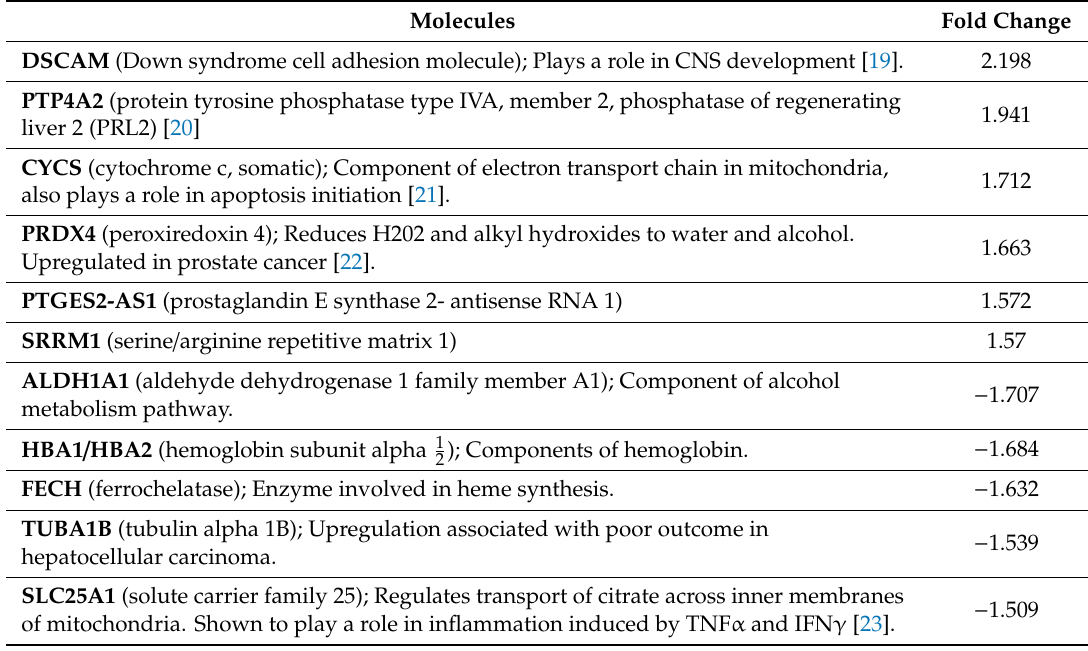
Table 1. Top upregulated and downregulated proteins following PXDN knockdown identified using IPA. Molecules Fold Change